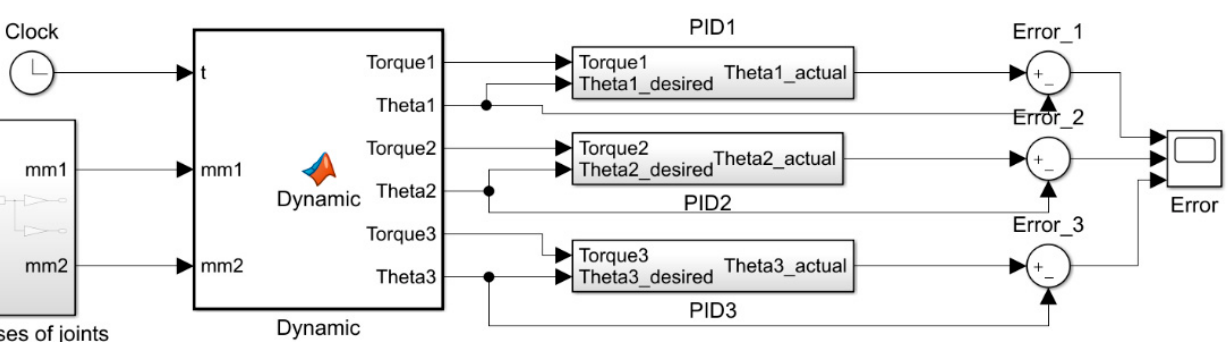
Figure 5. A discrete-time control scheme.